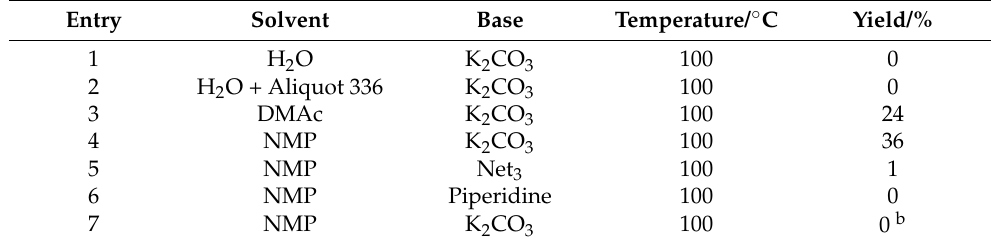
Table 3. Summary of the reaction conditions for the optimization of the Mizoroki–Heck reaction a .